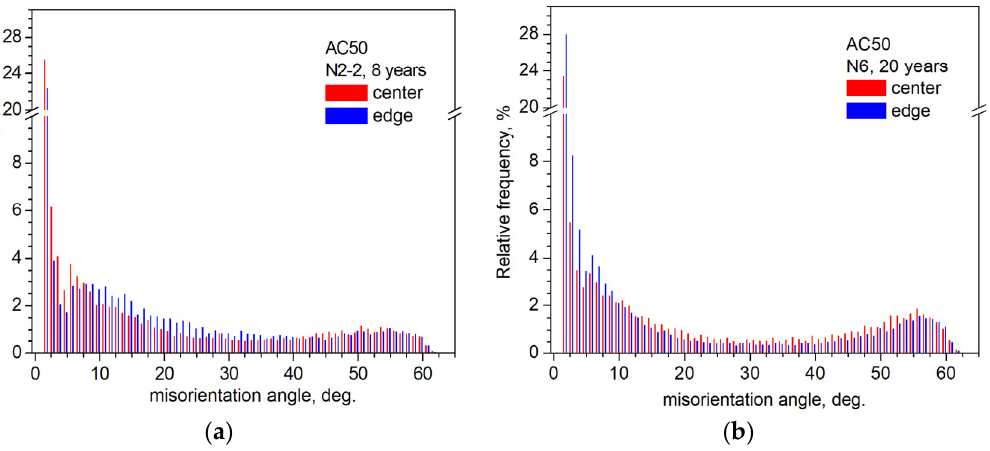
Figure 6. Histograms of grain boundary misorientation angle distribution for the centers and edges of